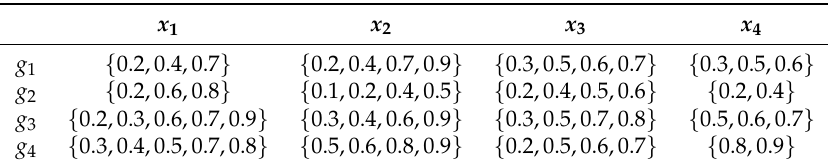
Table 1. Hesitant fuzzy decision matrix D